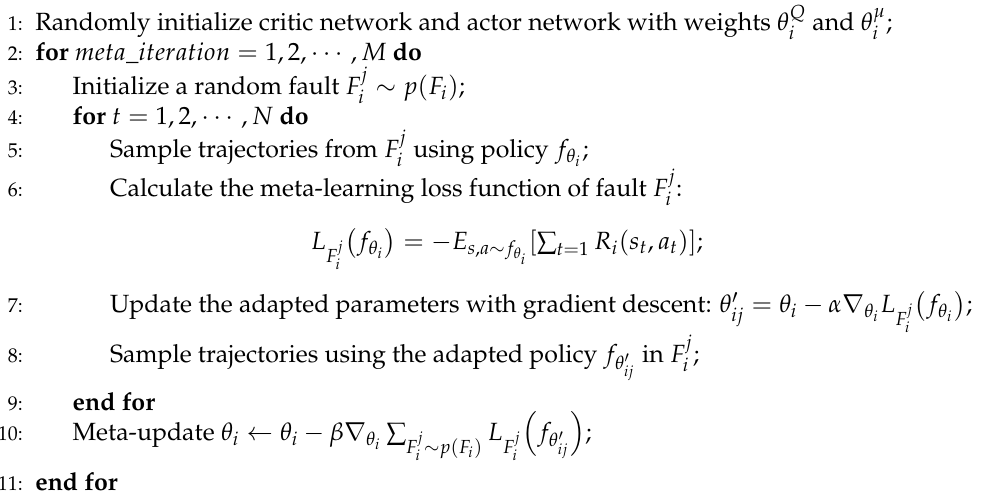
Algorithm 1 Meta-training of meta-DDPG algorithm in fault situation F i